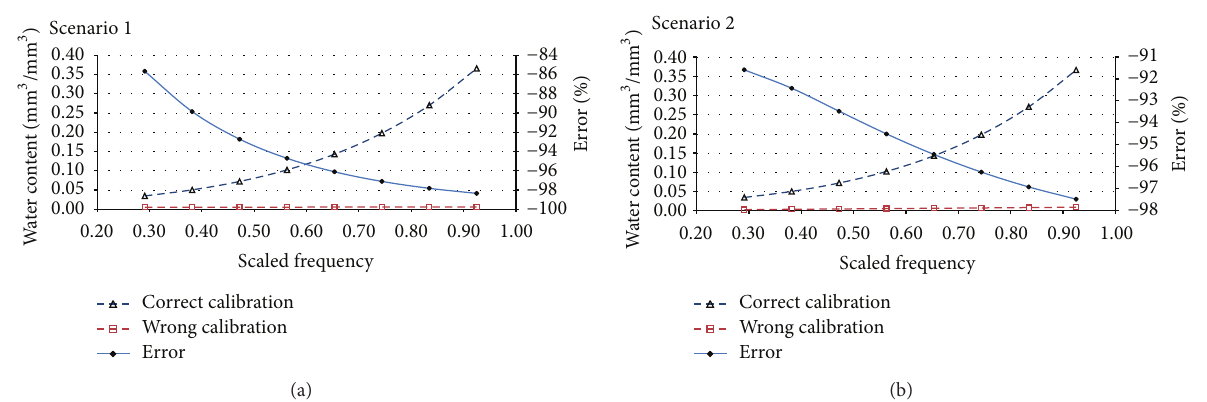
Figure 4: Comparison between calibrated and faulty readings of EnviroSCAN probe for Scenarios 1 and 2.